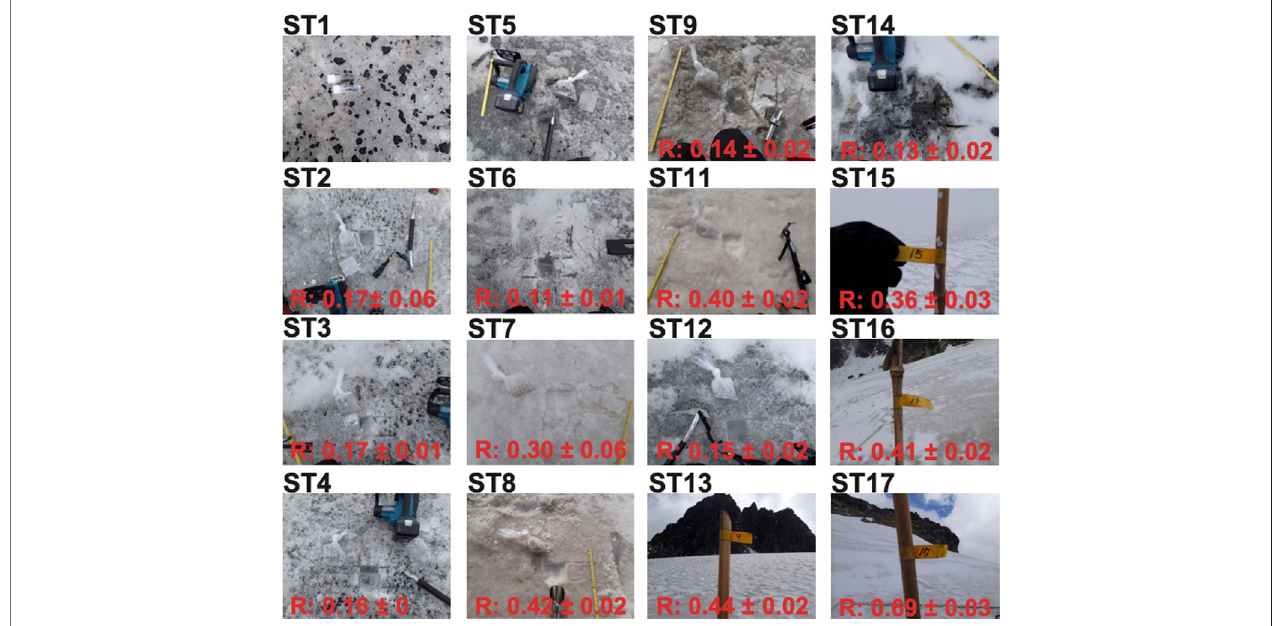
FIGURE4| SurfaceconditionateachsamplingsiteonStanleyGlacier.Measuredre fl ectivity(R)isindicatedwithstandarddeviationatthebottomofeachimage(no re fl ectivity measurements were conducted at ST1 and ST5). All images were taken in February